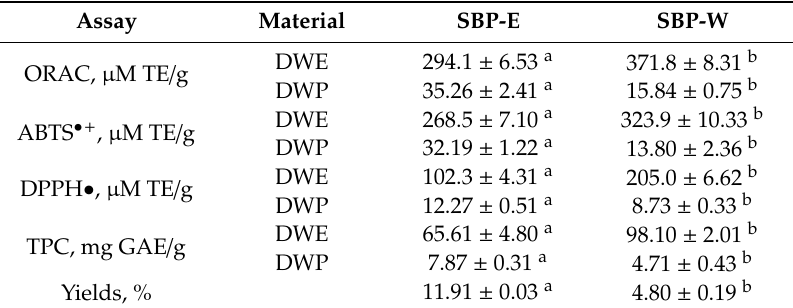
Table 1. Yield, phenolic content and antioxidant capacity of SBP extracts.